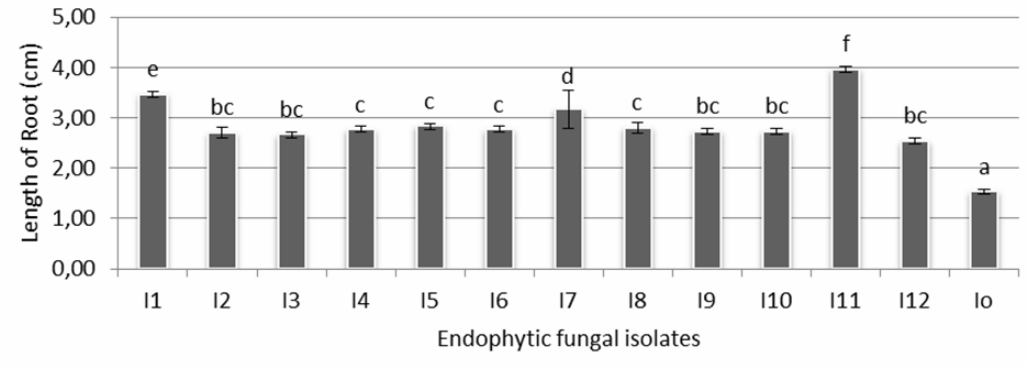
Fig. 4. The influence of endophytic fungi isolates on rice seedling growth (root